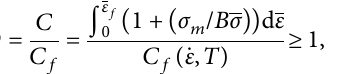
Figure 5: Critical fracture strains at different temperatures and strain rates for as-cast 42CrMo steel. (a) Experimental critical fracture strain. (b) Calculated critical fracture strain.